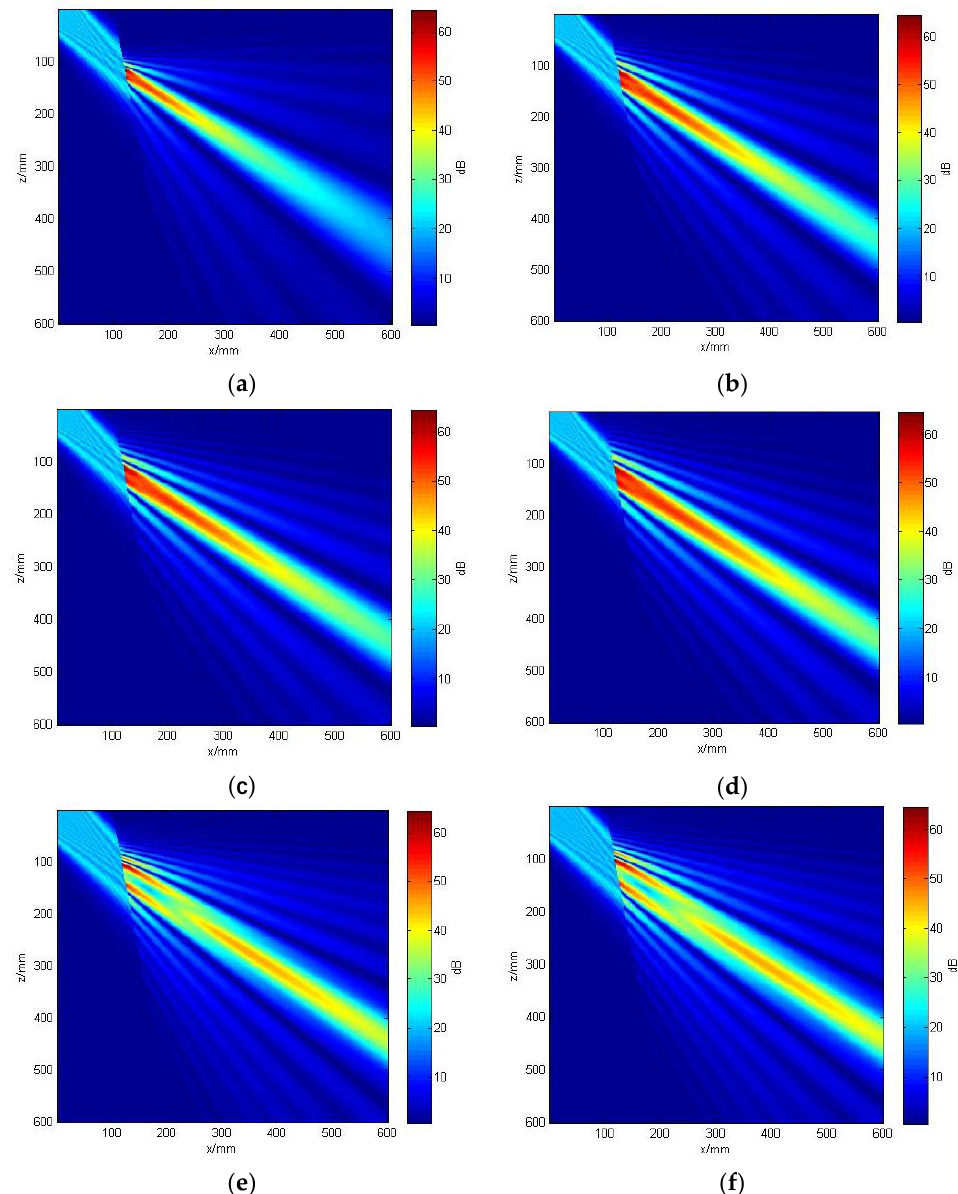
Figure 8. The acoustic field in materials with different curvatures: ( a ) acoustic field in material with a curvature of 1/0.35, with element width of 4 mm, and element length of 13 mm; ( b ) acoustic field in material with a curvature of 1/0.45, with element width of 4 mm, and element length of 13 mm; ( c ) acoustic field in material with a curvature of 1/0.5, with element width of 4mm, and element length of 13 mm; ( d ) acoustic field in material with a curvature of 1/0.6, with element width of 4 mm, and element length of 13 mm;( e ) acoustic field in material with a curvature of 1/0.45 with element width of 5 mm, and element length of 15 mm; ( f ) acoustic field in material with a curvature of 1/0.5, with element width of 5 mm, and element length of 15 mm.